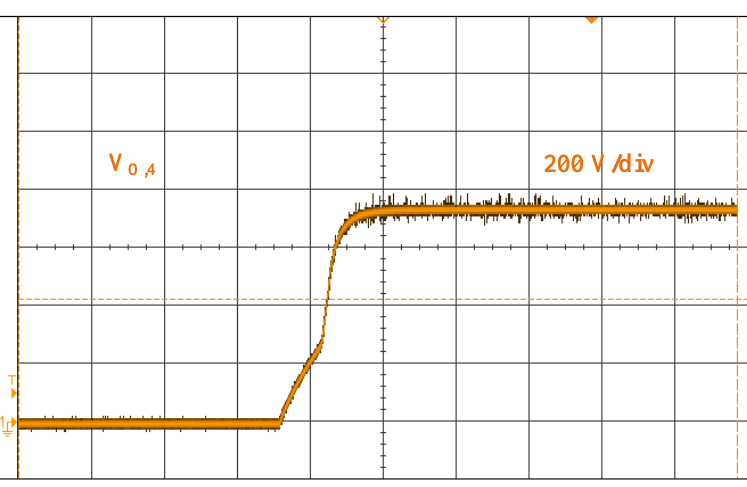
Figure 14. Output voltage V o,3 of stage 3.